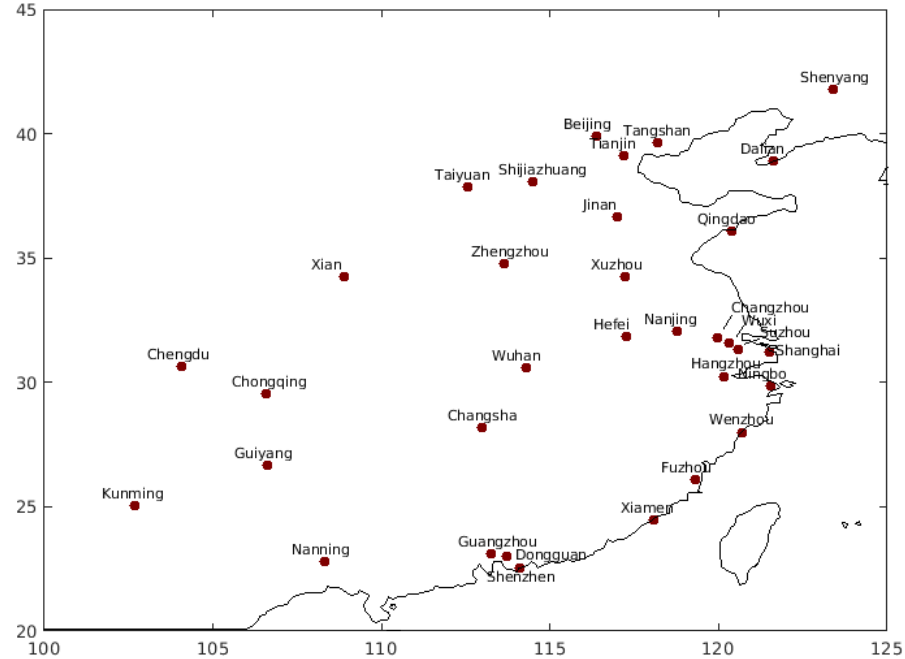
Figure 1. Map of the 34 cities/urban clusters (population over 3million, 2010 census) with available data (observational and model ensem- bles), used in this